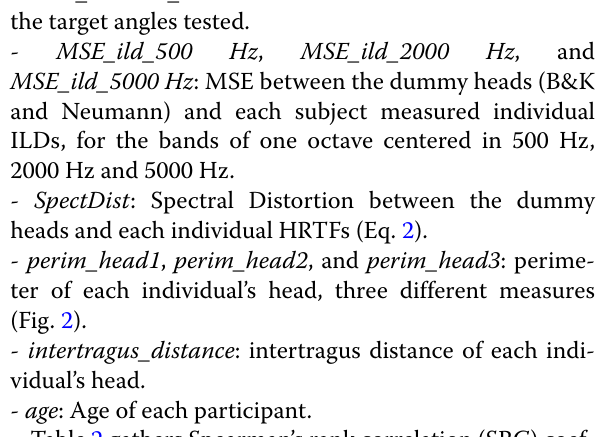
Table 2 gathers Spearman’s rank correlation (SRC) coef- ficients of the MSE_answers_varitd variable with all the others. The sign of the coefficient indicates the direction of association between the two variables (positive for a direct rank correlation and negative for an inverse one, between +1 and − 1). Thus, the variables that present a stronger relationship are those that have a higher abso- lute value, and those that have a weaker relationship are the ones that show coefficients closer to zero. In the table the values have been ordered from highest to lowest, with the extreme coefficients being those with tral values (lower correlation). Those variables for which in the tables with a dash ( − ). Std and cluster